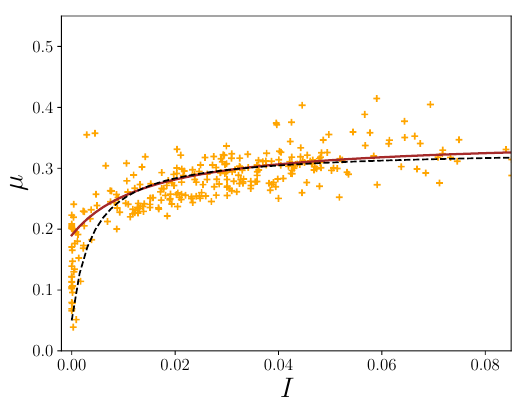
Figure 4. Coe  cient of friction µ computed in the neighbour- hood of the centre of mass plotted against the inertial number I . µ 1 ) / ( I 0 + 1) is shown in dotted The best fit for µ = µ 1 + ( µ 2 I  line, and an acceptable trend is obtained in red for more classical values for the static friction µ 1 (see